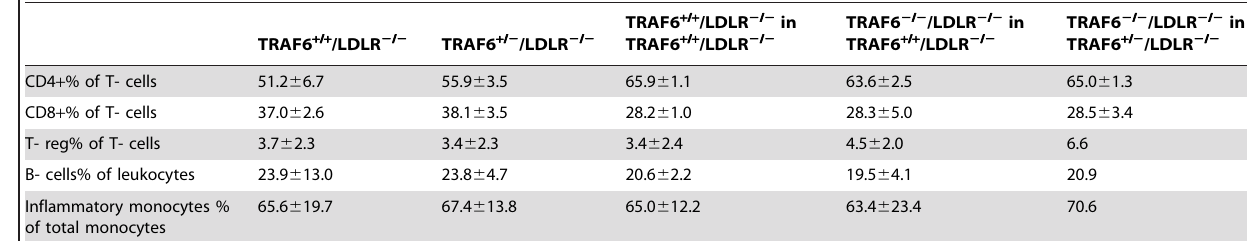
Table 1. Subtypes of blood